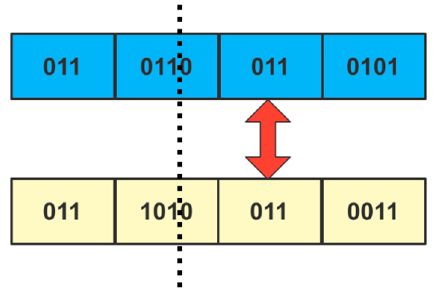
Figure 9. Property fields for the two alarm records waiting for a crossover operation.